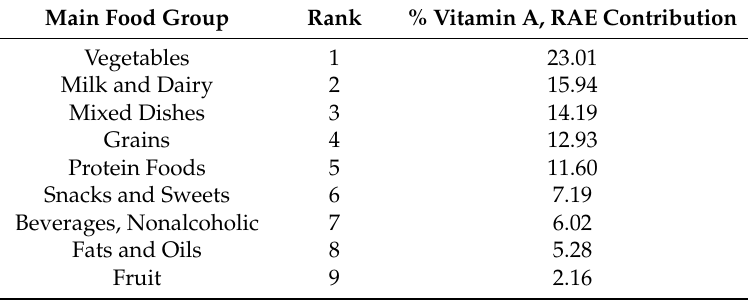
Table 10. Food sources of vitamin A, retinol activity equivalents (RAE), contribution in the total U.S. diet, adults ≥ 51 years old ( n = 4522; gender combined; daily intake data; NHANES 2011–2014; main food groups contributing <1.0% not reported; data are Day 1